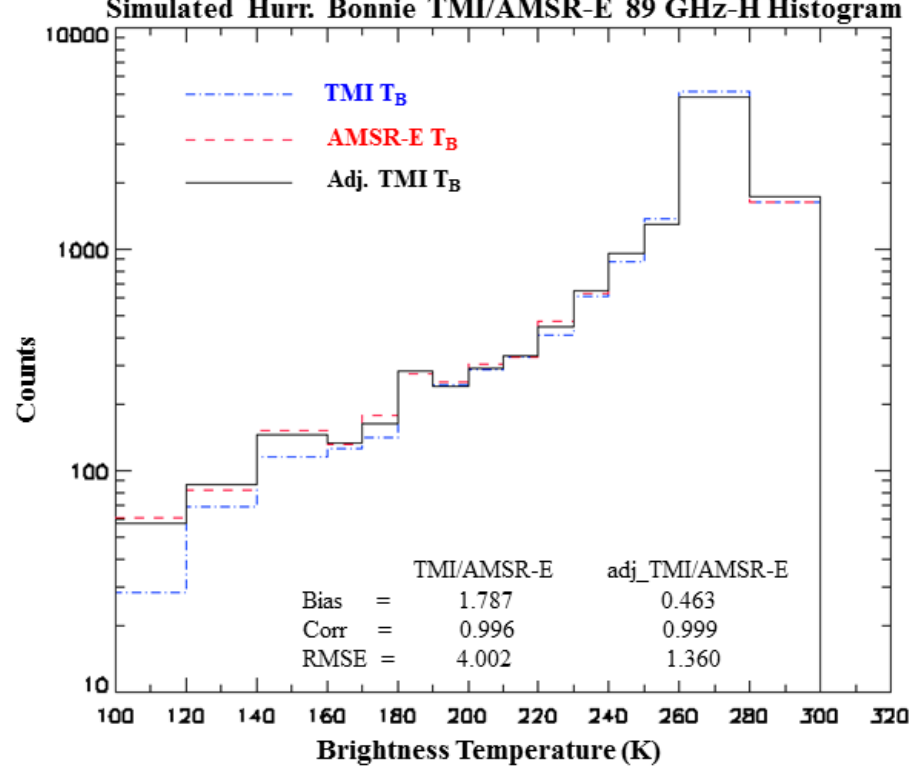
Figure 11. Histogram Comparison of the simulated TMI, adjusted TMI, and AMSR-E T for hurricane